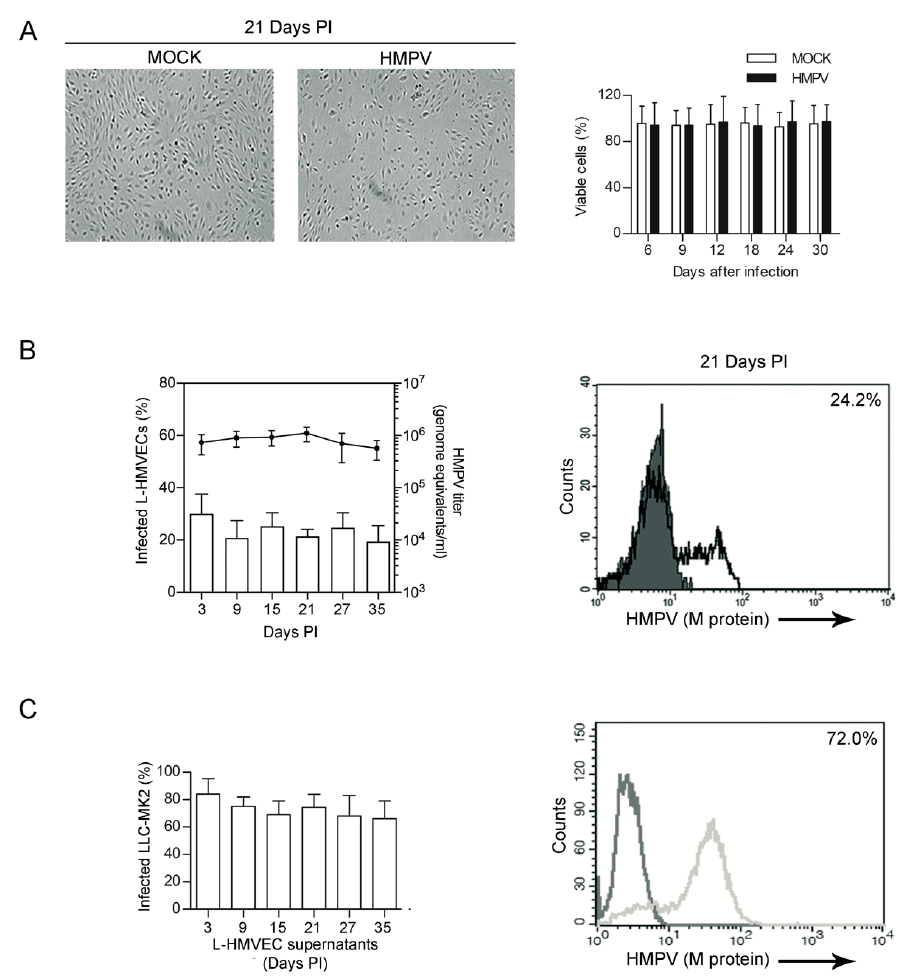
Figure 2. HMPV persistent infection of L-HMVECs ( A ) Left panel: Light microscopy evaluation of mock and HMPV-infected monolayers. At the third week of infection (day 21 PI), infected cells appear less abundant, but retain the EC characteristic morphology (Scale Bar = 50 μ m). Right panel: Bars represent % of mock ( □ ) and HMPV-infected ( ■ ) viable cells at the indicated time points, as assessed by trypan blue exclusion assay. ( B ) Release of virus by long term cultured L-HMVECs. Left panel: Bars (left axis scale) indicate the % of HMPV-infected L-HMVECs, as assessed by flow cytometry, at the indicated time of collection. Line (right axis scale) are mean viral loads (number of genome copies per mL of supernatant) at the indicated time of collection. The viral titer in culture supernatant was always determined 72 h after the culture medium was changed. Data are means ± SD from 3 independent experiments. Right panel: Representative flow cytometric analysis of infected L-HMVECs at 21 days PI. HMPV M antigen expression was evaluated as described in Figure 1. Percentage of HMPV + cells is shown in the panel upper right corner. ( C ) Release of infectious particles by persistently infected L-HMVECs. LLC-MK2 were exposed for 3 h to the supernatants of HMPV- infected L-HMVECs collected at different time points. After six days, the rate of HMPV-infected LLC-MK2 cells was quantified by flow cytometry. Left panel: Bars represent the mean ± SD of the % of infected LLC-MK2 detected in 3 independent experiments. In the horizontal axis are indicated the day of harvesting of HMPV-infected supernatants from L-HMVECs. In the right panel a representative histogram of LLC-MK2 infected with supernatants from HMPV-infected L-HMVECs at 21 days PI is shown. Light histogram represents data obtained from LLC-MK2 exposed to supernatants derived from mock L-HMVECs.